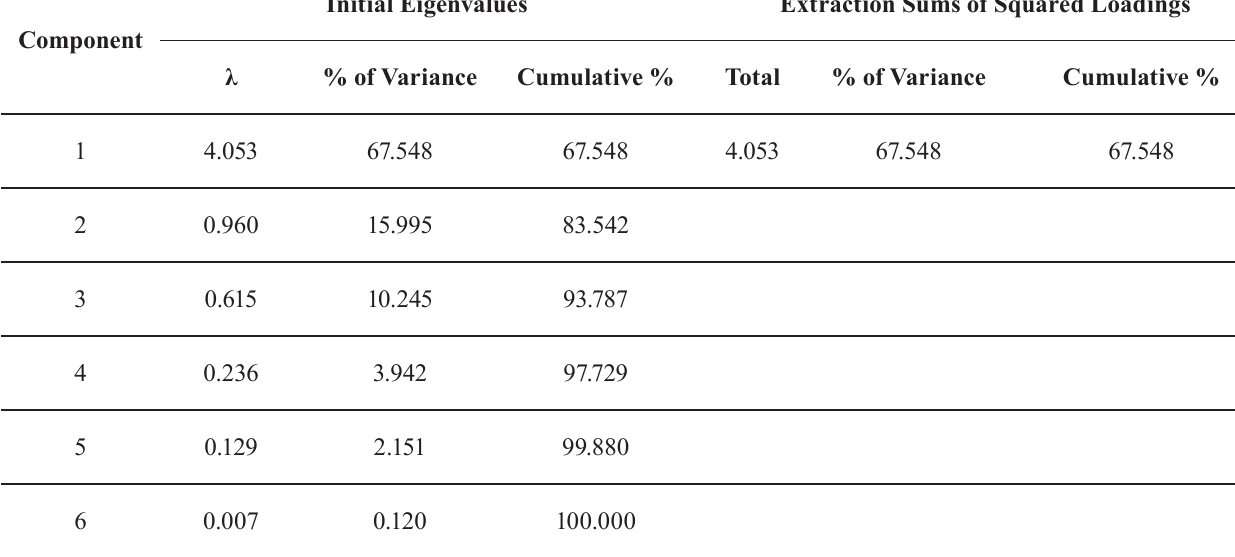
Initial Eigenvalues Extraction Sums of Squared Component